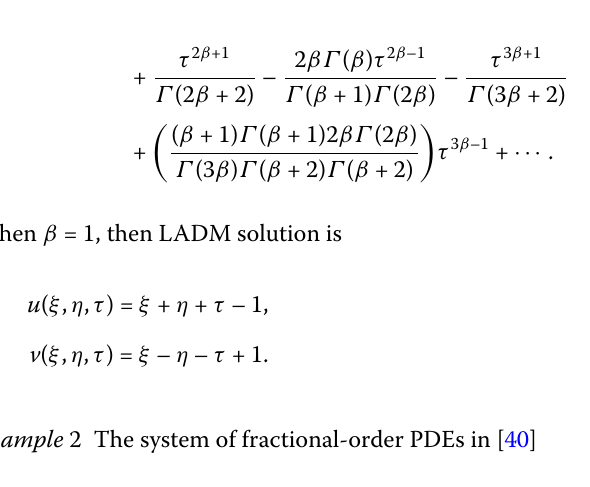
Figure 2 The ( c ) exact and ( d ) LADM solution graph of Example 1 of v at β = 1 and τ =